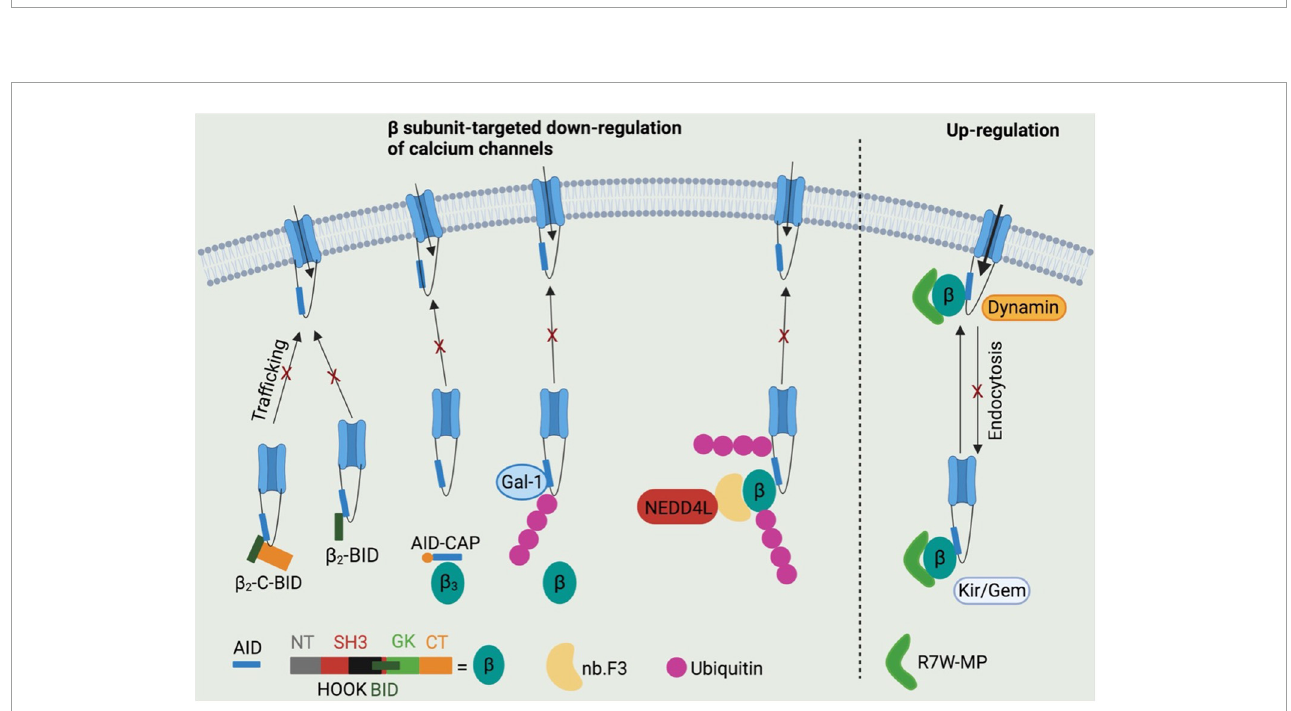
FIGURE4 Potential β subunits-targeted therapeutic development through modulating calcium channel functions. β 2 -C-BID and β 2 -BID, lacking for the channel trafficking-required motifs, occupy the β subunits-binding sites within AID domain, thereby leading to reduced trafficking of channels to cell surface. Stapled AID peptides disrupt the interactions between calcium channels and β 3 subunits, but not β 2 subunits, which also results in down-regulation of calcium channel function. Galectin-1 is able to displace β subunits from calcium channels by binding to exon 9 C-terminus and thus to inhibit channel function by exposing lysines within I–II loops to ubiquitination. A β subunit-binding nanobody nb.F3 fused with catalytic domain of NEDD4L E3 ligase significantly blocks the calcium channel function by strongly enhancing the ubiquitination level. R7W-MP peptide, which binds to tail-binding domain (TID) domain within the β 2 subunit Src homology 3 (SH3) domain, is able to up-regulate calcium channel function via multiple mechanisms, such as preventing channel degradation via ubiquitin-protease system, inhibiting the channel endocytosis by displacing dynamin from β subunits and facilitating the channel trafficking to cell surface by displacing Kir/Gem from β